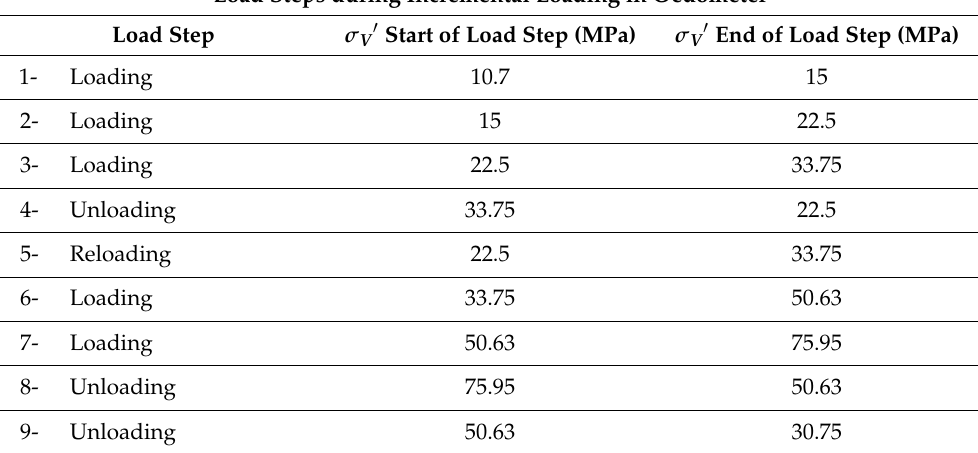
Table 2. Various load steps used in the incremental loading oedometer test on the vertical Draupne shale